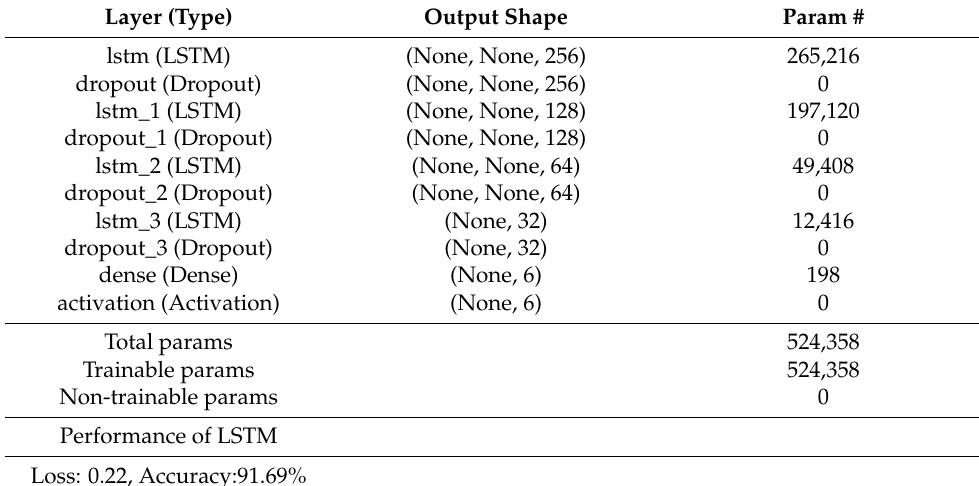
Table 4. Summary of model parameters based on fine-tuned LSTM neural